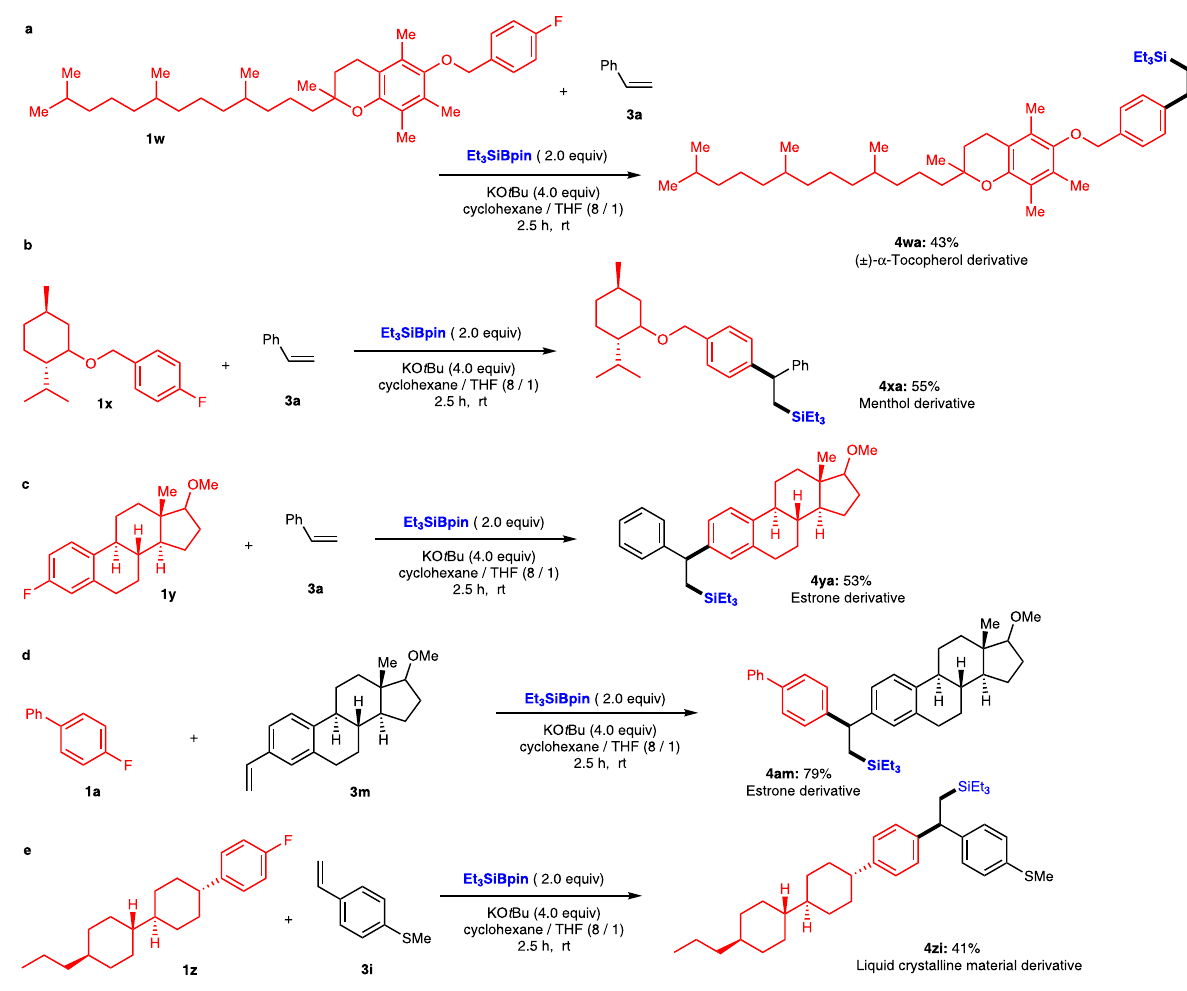
Fig. 3 Substrates relevant to medicinal or materials chemistry. a (±)- α -Tocopherol derivative. b Menthol derivative. c , d Estrone derivatives. e Liquid crystalline material